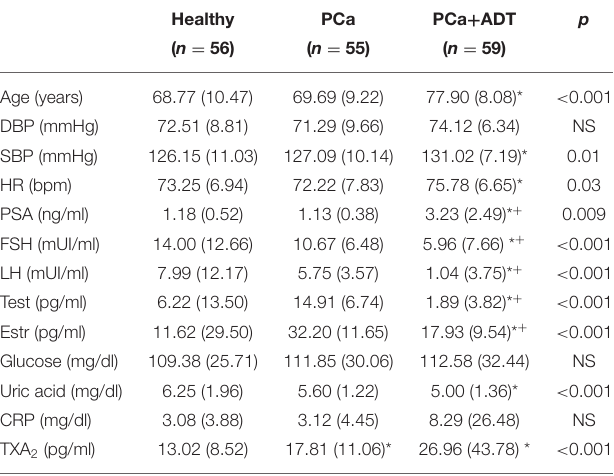
TABLE 1 | Characteristics of the study